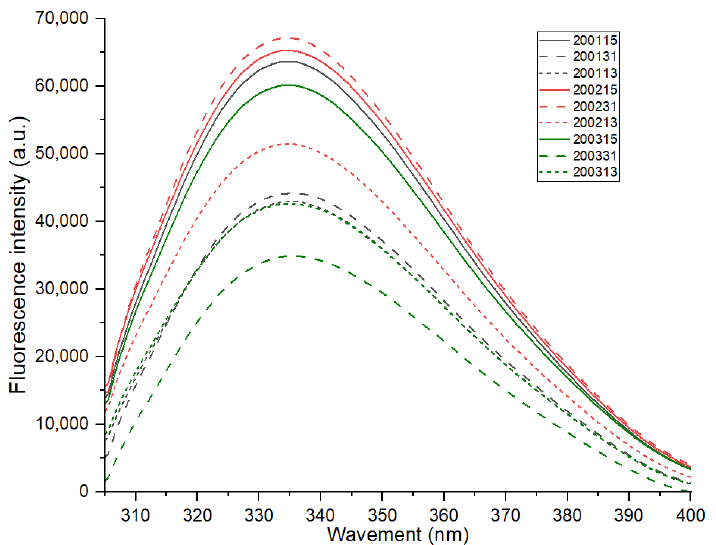
Figure 2. Fluorescence spectra of the recombinant